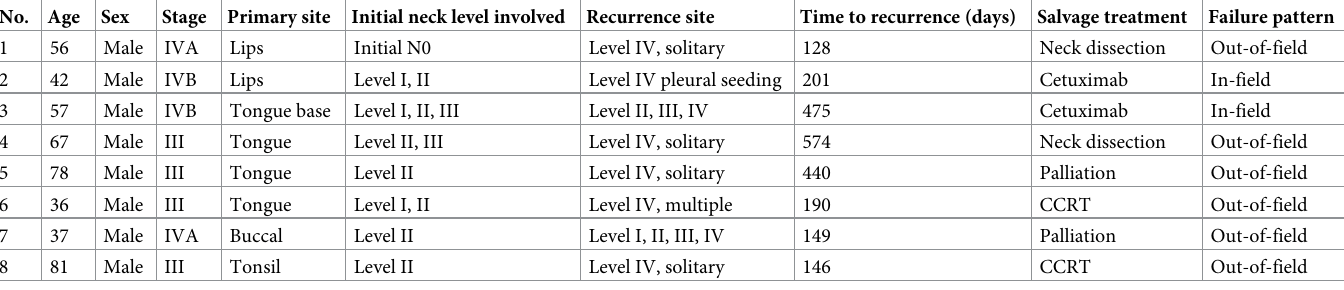
Table 4. Details of level IV